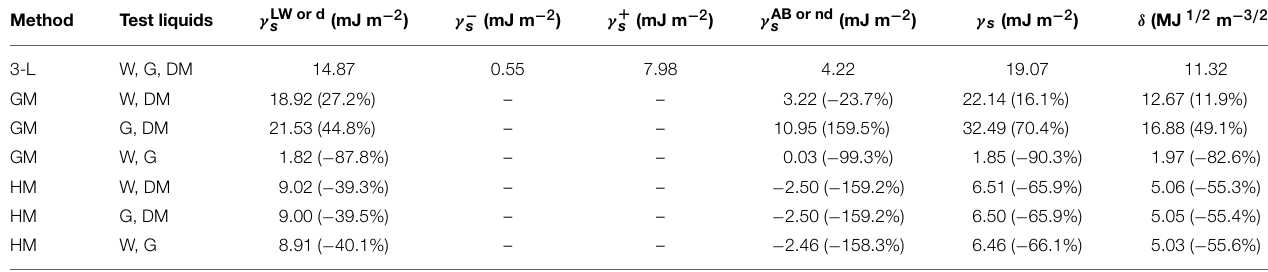
TABLE 4 | Surface free energy ( γ s ) and its components ( γ LW or d s